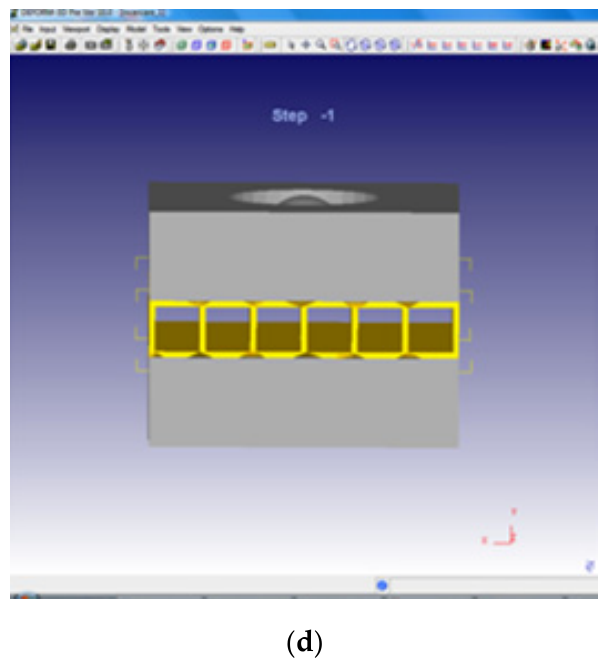
Figure 2. Model design. ( a ) Geometrical model for the equivalent continuous material. ( b ) Impactor position on connection layer. ( c ) Impactor position between connection layers. ( d ) Aspect of processed model.